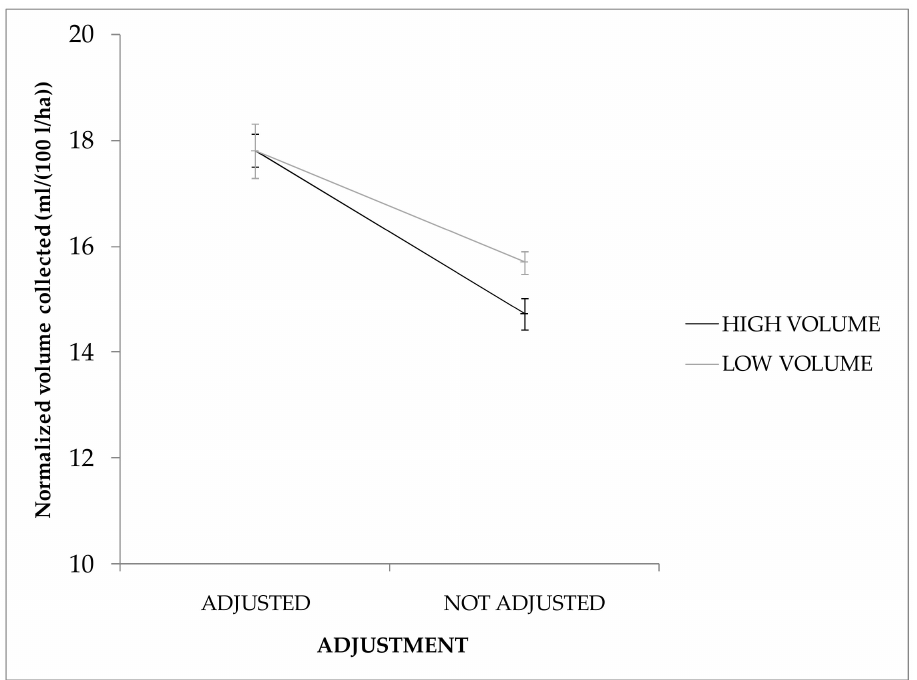
Figure 12. Adjustment × Volume rate interaction effect on the normalized volume collected in the canopy zone (mean ± SE) with the T sprayer.